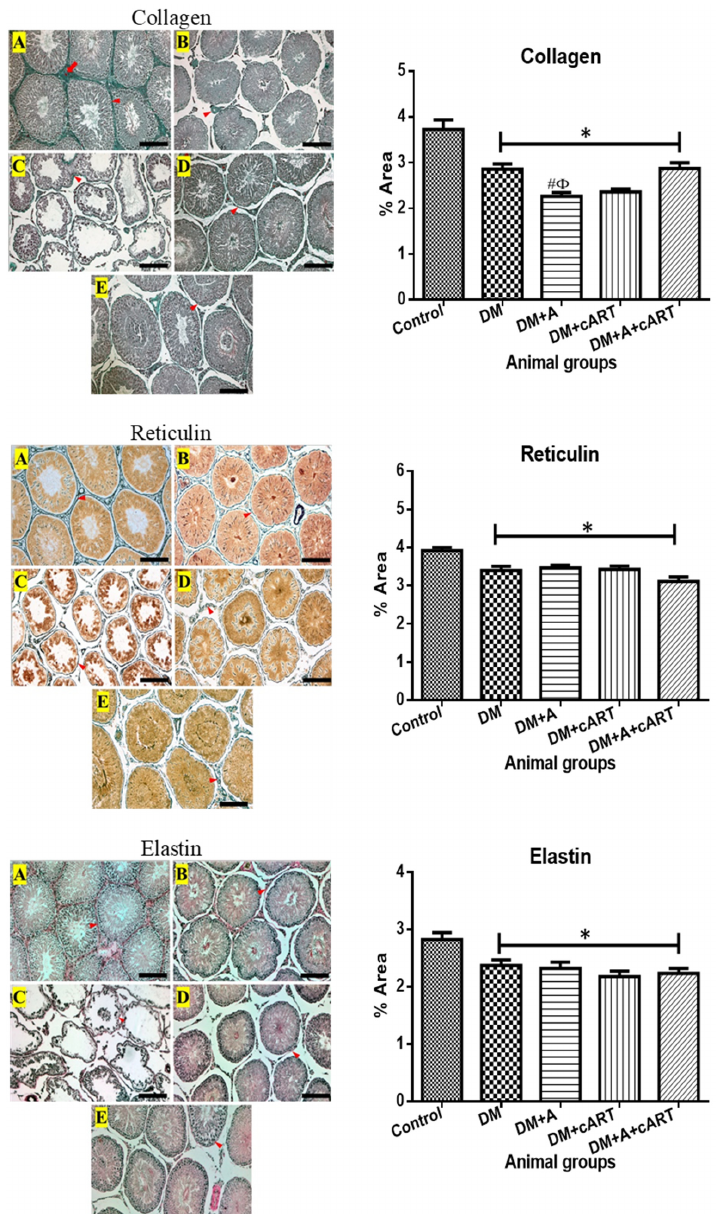
Figure 4. Representative collagen, reticulin, and elastin indicated with arrowheads in a photomi- crograph, Masson’s trichrome, Gordon and Sweet’s silver impregnation, and Verhoeff Van Gieson stain, respectively. The graphs show the respective mean ± SEM percentage area values. *, #, and φ represent significant differences ( p < 0.05) as analyzed by the Bonferroni’s multiple compar- ison test: ‘*’ significantly reduced compared to the control gorup, ‘#’ significantly reduced com- pared to DM, and ‘ φ ’ significantly reduced compared to DM+A+cART. Magnification, × 100; scale bar, 200 µ m. Key: Image: ( A ); control group, ( B ); DM group, ( C ); DM+A group, ( D ); DM+cART group, and ( E ); DM+A+cART group. DM, diabetes; DM+A, diabetes and alcohol; DM+cART, dia- betes and combination antiretroviral therapy; DM+A+cART, diabetes and alcohol and combination antiretroviral